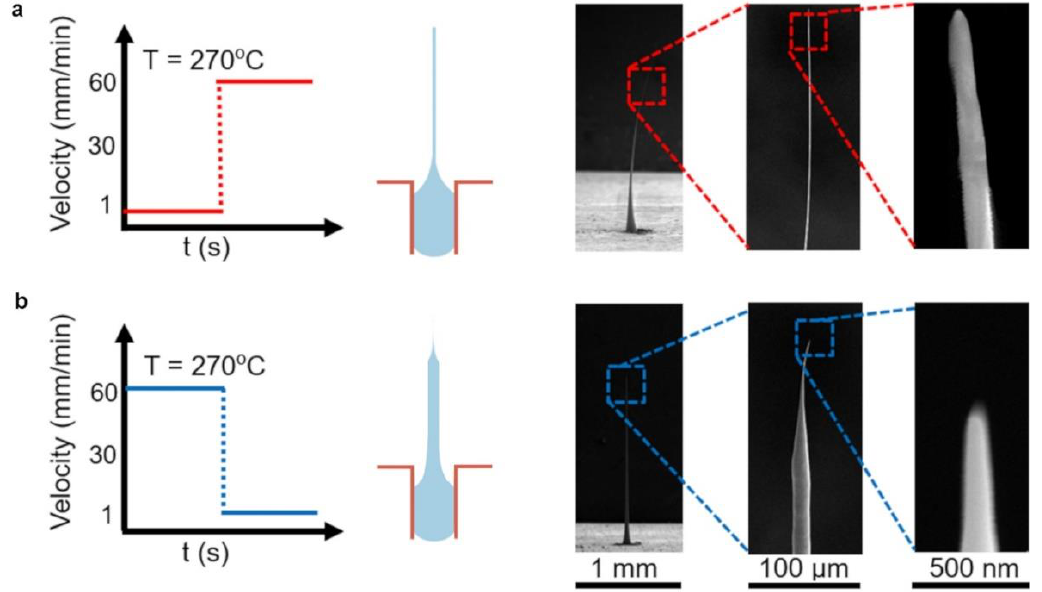
Figure 9. Effect of variable drawing velocity on the shape of Pt-BMG fiber. ( a ) Increase in drawing velocity from 1 to 60 mm/min results in formation of long nanowire (diameter ~150 nm, length > 200 µm). ( b ) A microfiber with nanotip (~75 nm) is formed upon decreasing the drawing velocity from 60 to 1 mm/min.